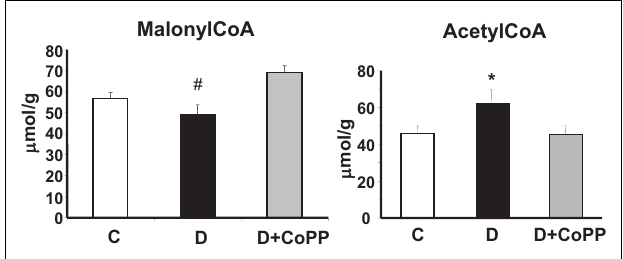
FIGURE 6 | Effect of CoPP on malonyl-CoA and acetyl-CoA in hearts isolated from C, D, and D + CoPP animals. Data are expressed as means ± SEM of three independent determinations # p < 0.01 D vs. other groups; * p < 0.05 vs. other